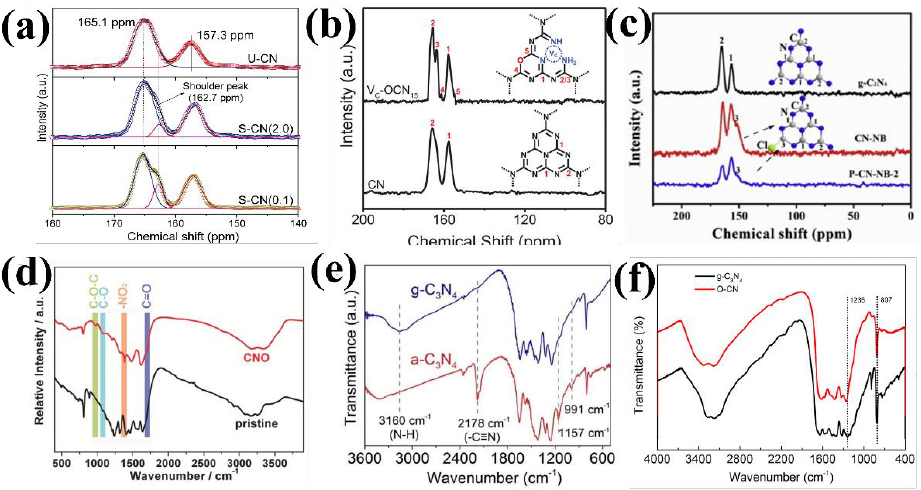
Figure 10. ( a ) Solid-state 13 C NMR of U – CN and S – CN [93]. ( b ) 13 C CP-MAS NMR spectra of